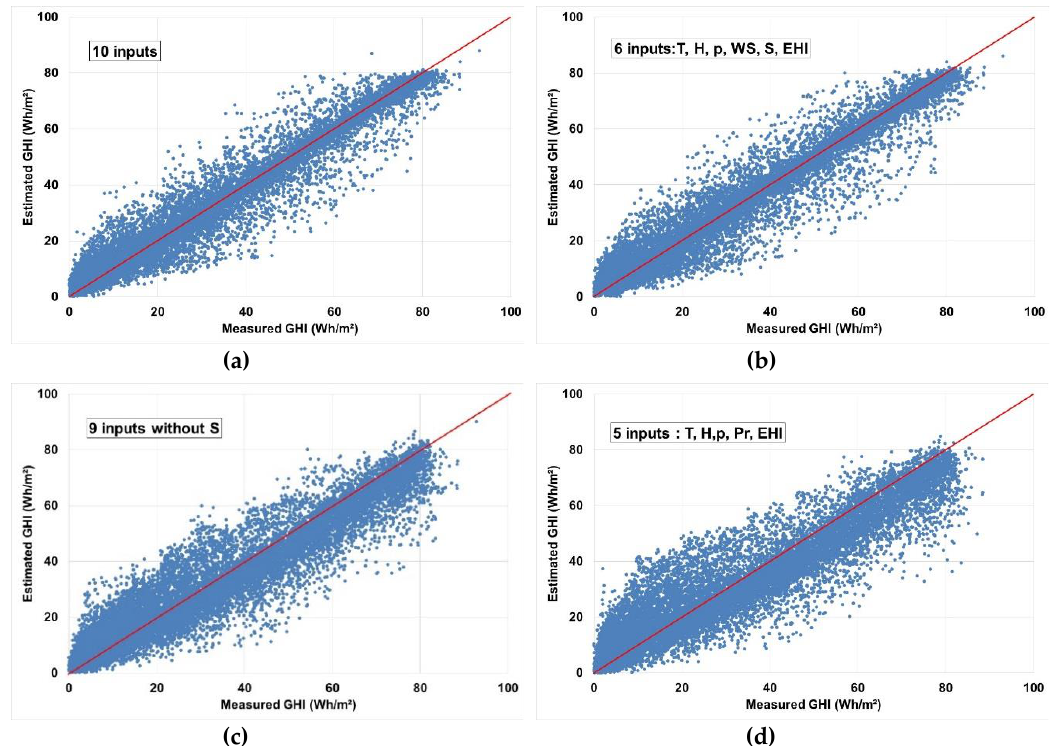
Figure 5. Estimated 5-min GHI versus measured 5-min GHI for various ANN architectures (Bouzareah site); ( a ) using 10 inputs; ( b ) using 6 inputs (with S); ( c ) using 9 inputs (without S); ( d ) using 5 inputs (without